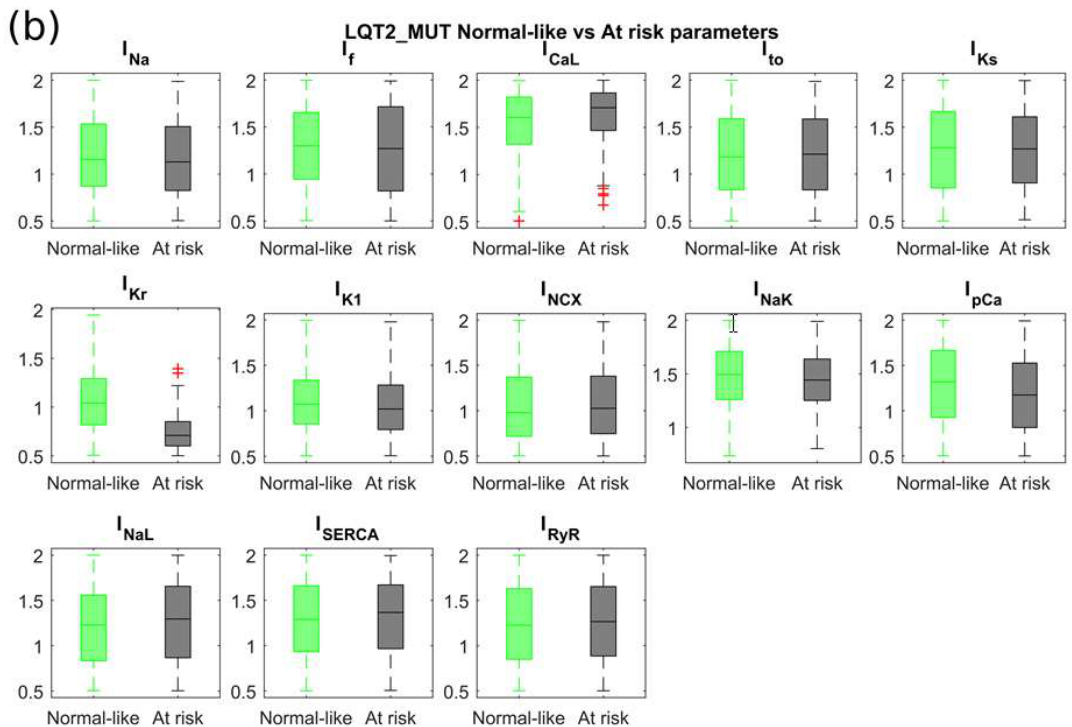
Figure 9. Distribution of the sampling coefficients of the maximum conductances/currents (see Section 4.4) for the main ionic currents in the at risk and normal-like groups into which LQT1_MUT and LQT2_MUT were split. For each population, we considered a median difference of at least 10% to identify the main ionic mechanisms that differ between the two groups. ( a ) LQT1_MUT: at risk models exhibited smaller I Kr ( − 25%) and larger I CaL (+41%). ( b ) LQT2_MUT: at risk models exhibited smaller I Kr ( − 32%) and I pCa ( − 11%). Outliers are represented as red crosses.